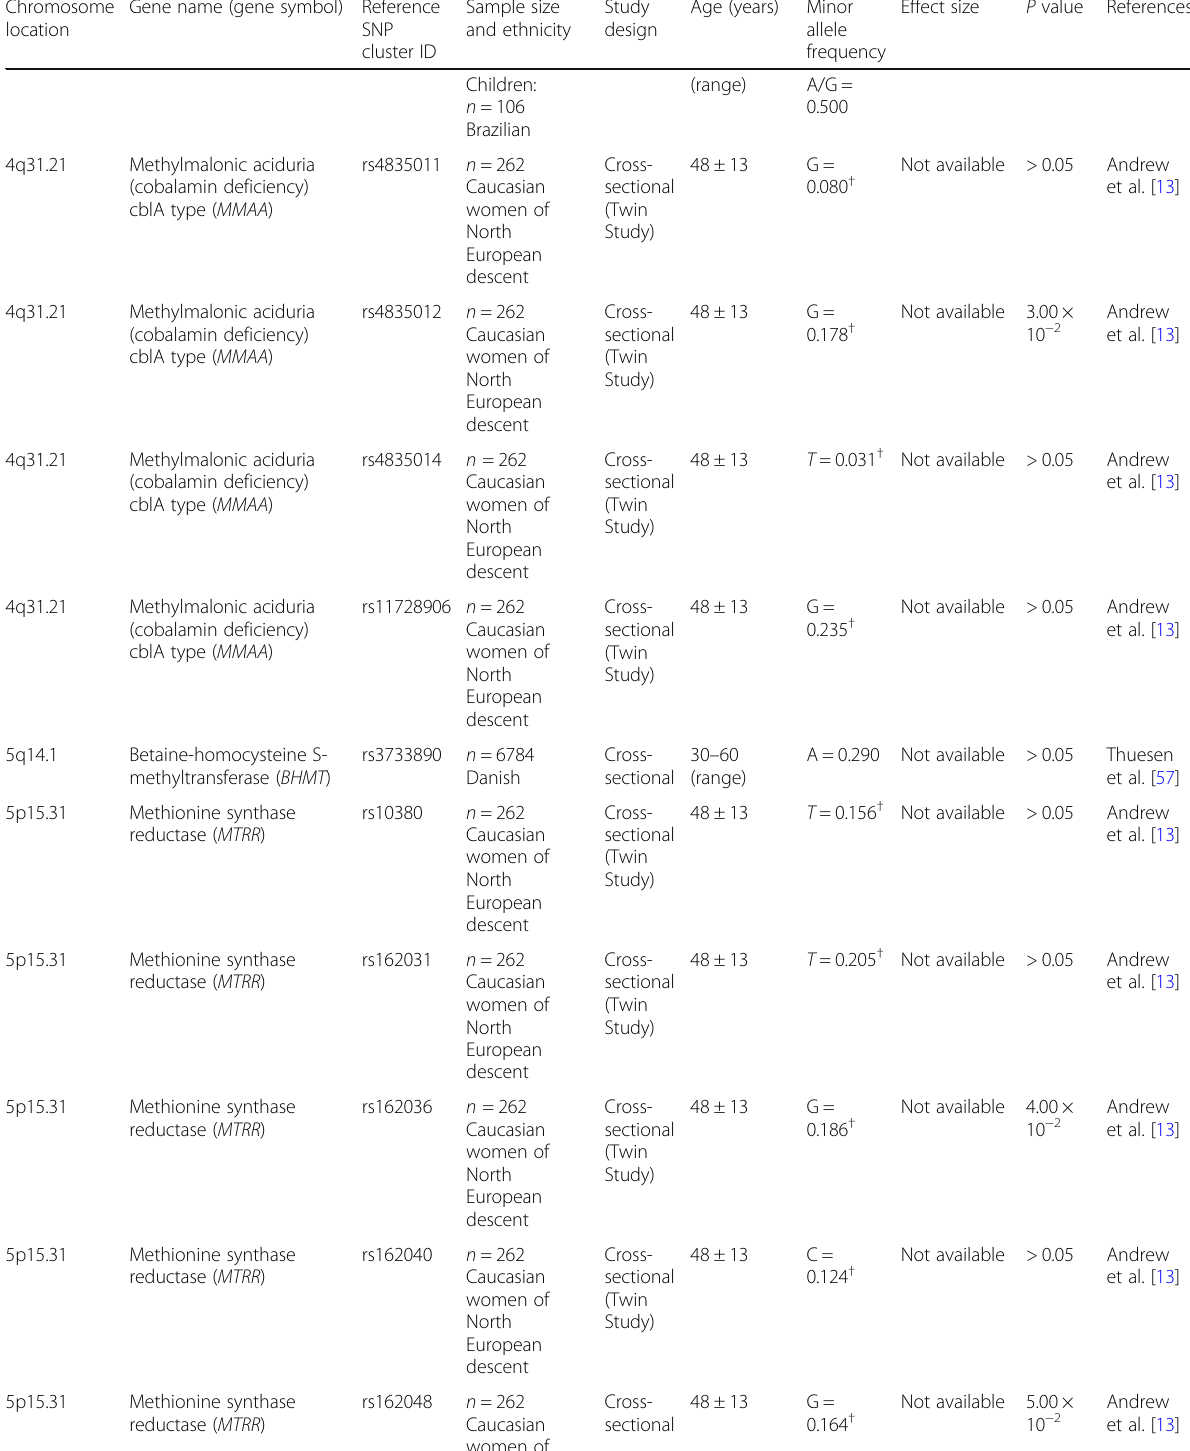
Table 2 Candidate gene association studies examining the association of SNPs with vitamin B12 concentrations. Candidate gene association studies testing the association between SNPs and vitamin B12 concentrations. The chromosome location, gene name, reference SNP cluster ID, sample size and ethnicity, study design, mean age, observed frequency of the minor allele in the population, effect size and P value are shown in the table. The order of SNPs reflects the order of the chromosome location